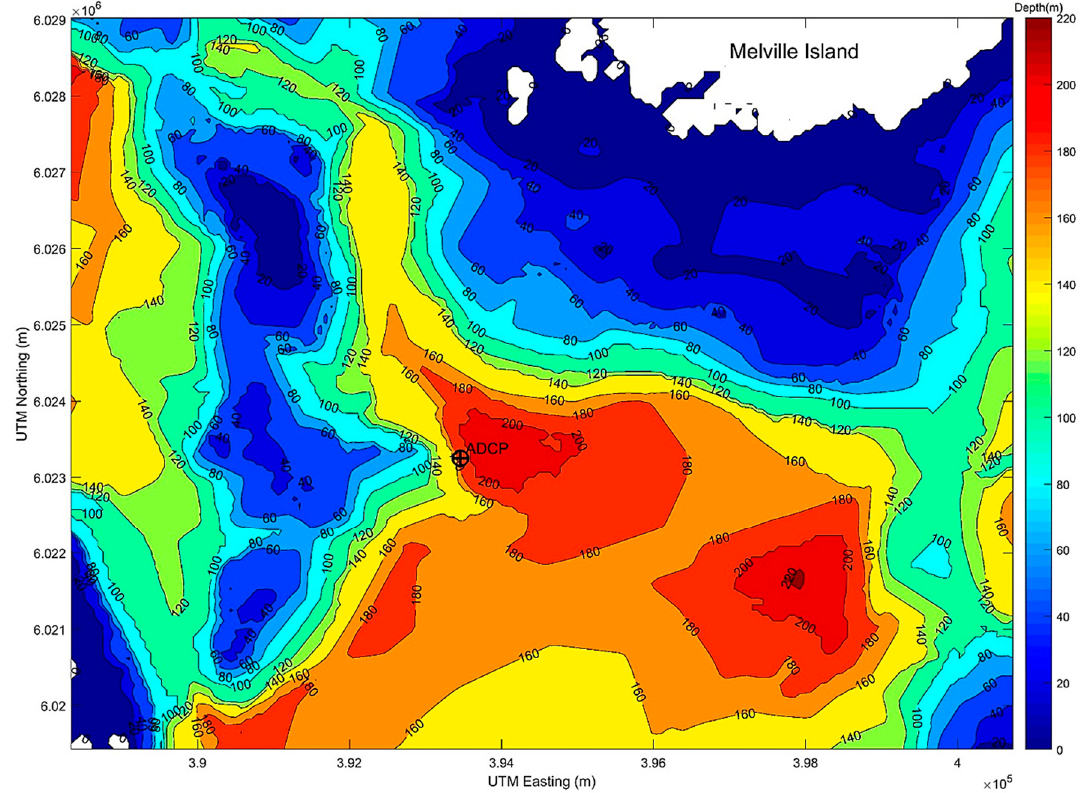
Figure 8. Study area including bathymetry (contours depths below chart datum) and the location of acoustic Doppler current profiler (ADCP) measurements.